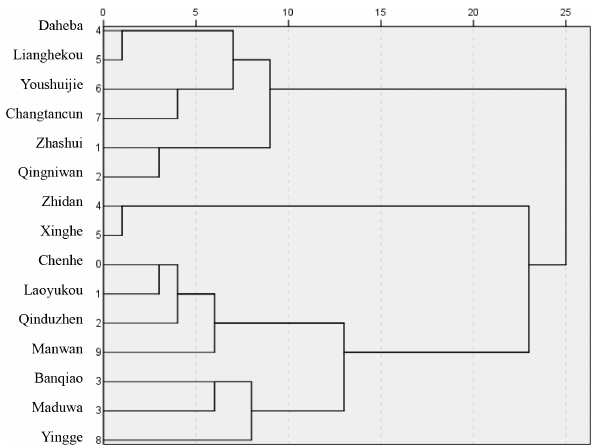
Figure 4. The dendrogram using Ward’s